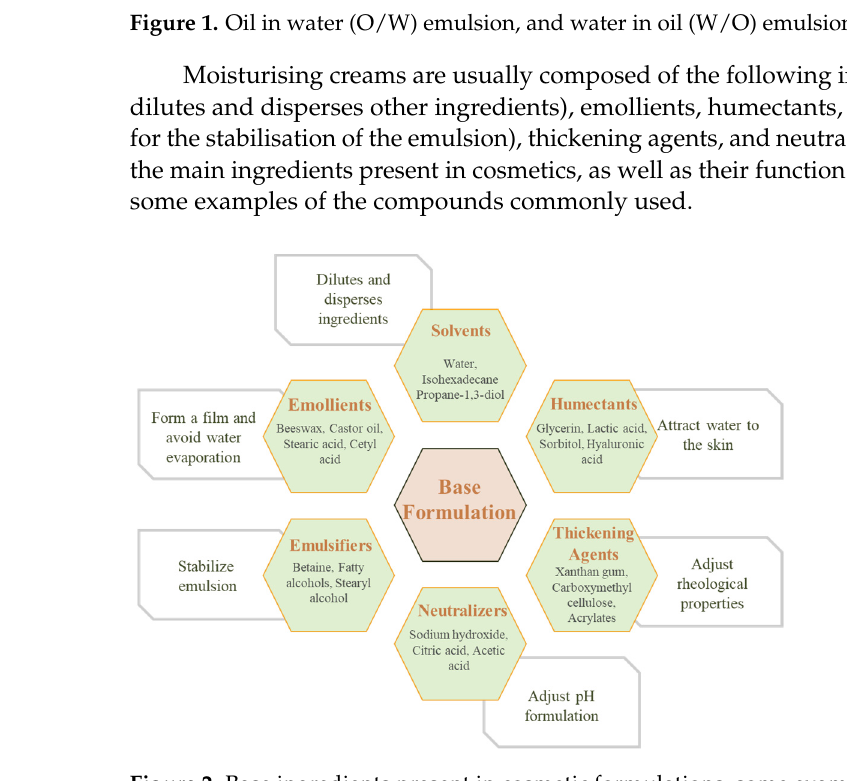
Figure 2. Base ingredients present in cosmetic formulations, some examples, and their function on the formulation.